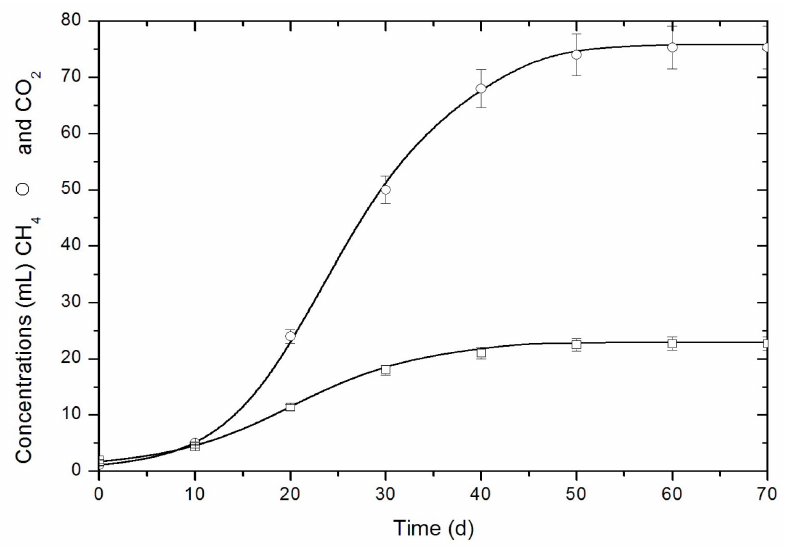
Figure 2. Real data (symbol) and predicted dynamics (continuous line) of CH 4 -CO 2